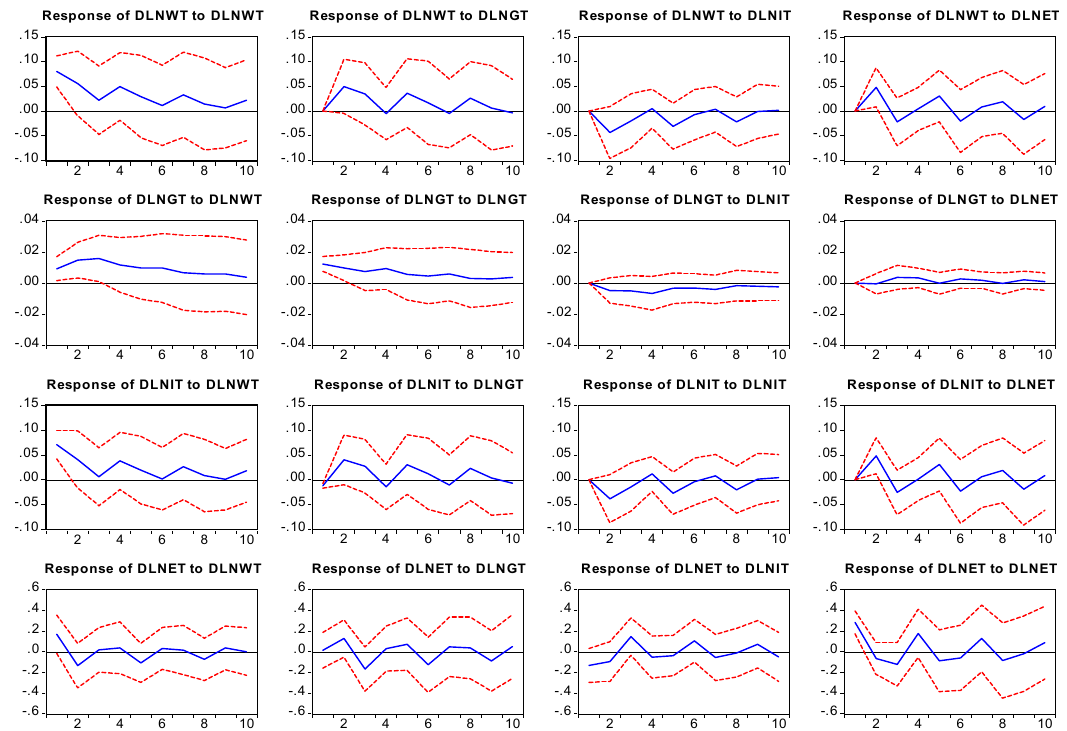
Figure 4. Responses of industrial water use to different influence factors. The blue solid lines indicate the mean responses to a one standard deviation shock, while the dotted lines represent ±2 standard deviations of the responses. The x-axis is the forecast horizon (in years), and the y-axis is the forecasted response of the dependent variable to a unit shock in the corresponding error term.